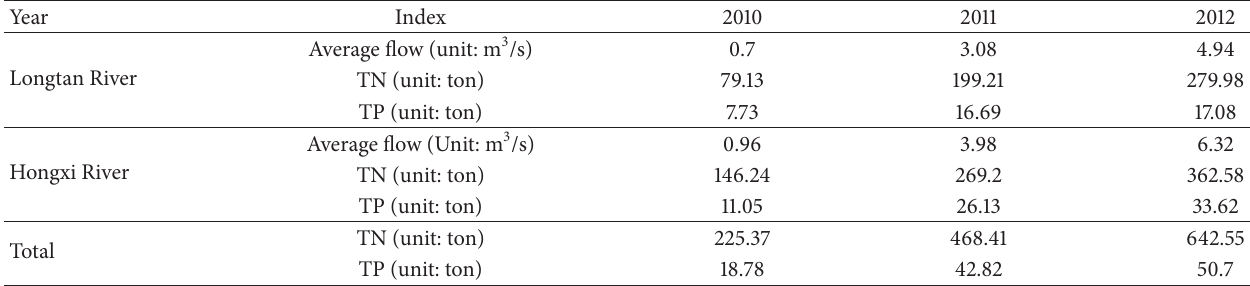
Table 4: The simulated results of pollutant loads in TN and